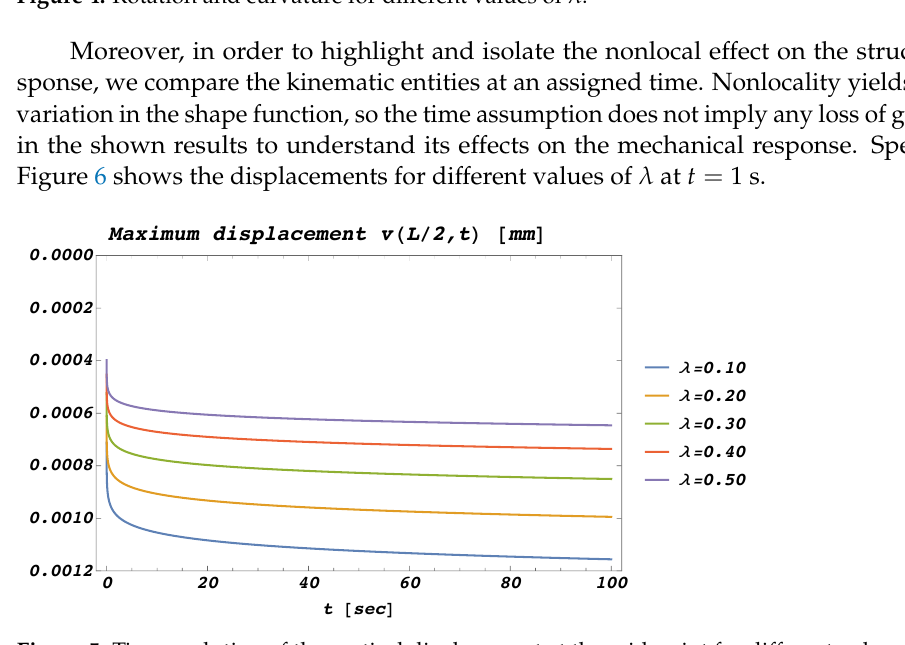
Figure 5. Time evolution of the vertical displacement at the mid-point for different values of λ .